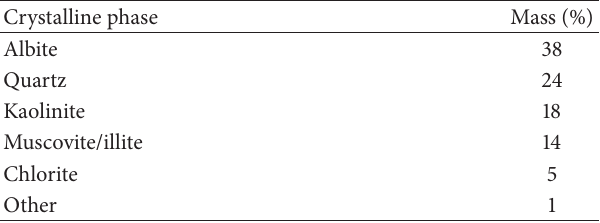
Table 2: Rational mineralogical analysis of spray-dried powder.